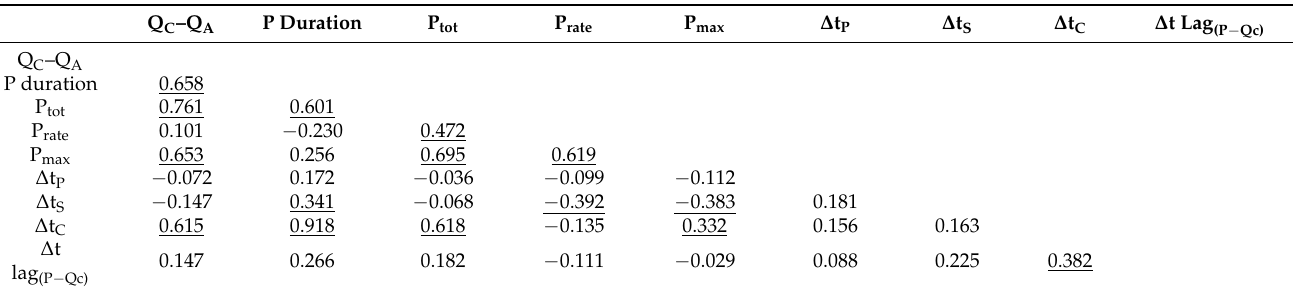
Table 3. Pearson correlation matrix of the precipitation and storm hydrograph parameters. The underlined values are significant at the 0.05 level.